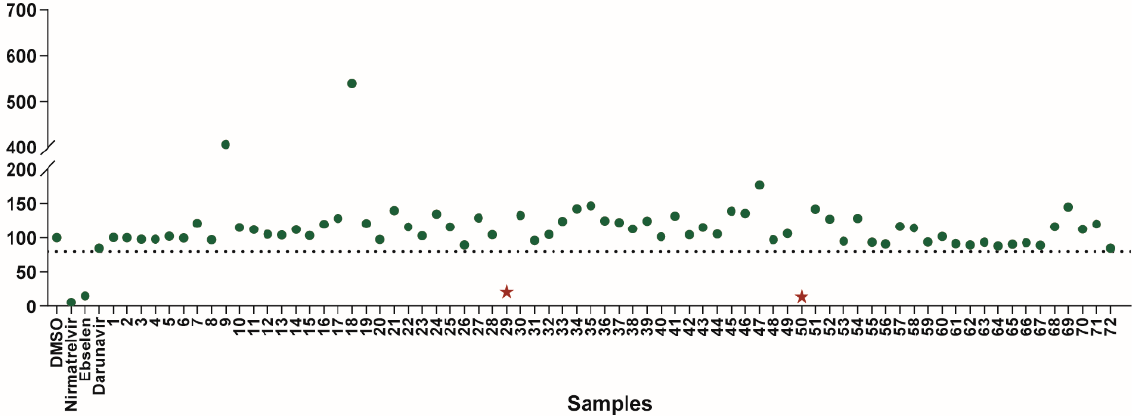
Figure 2. Results of the high-throughput screening. Twenty µ M of the compounds was pre-incubated with 100 nM of SARS-CoV-2 3CL pro for 30 min at 30 ◦ C, and then a 10 µ M FRET substrate was added to the reaction mixture to initiate the reaction. The reaction was monitored for 2 h. The initial velocity was calculated by linear regression using the data points from the first 15 min of the reaction. The calculated initial velocity with each compound was normalized to DMSO control. The results are the average of three repeats. The asterisk indicates 29# contains a polyphenol P2 ligand, and 50# contains a caffeine P2 ligand.